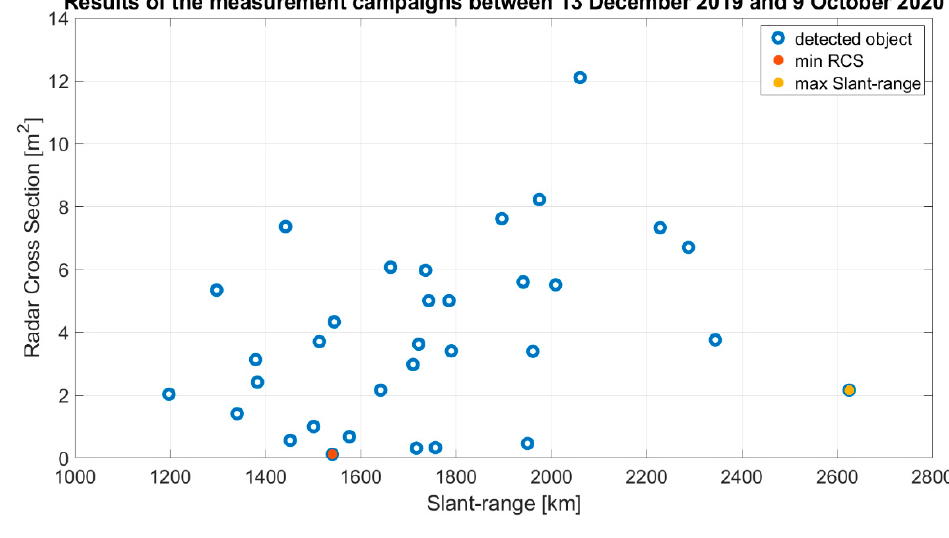
Figure 11. Results of the measurement campaigns between December 13, 2019 and October 9, 2020: distance of the detected objects as a function of its radar cross section.